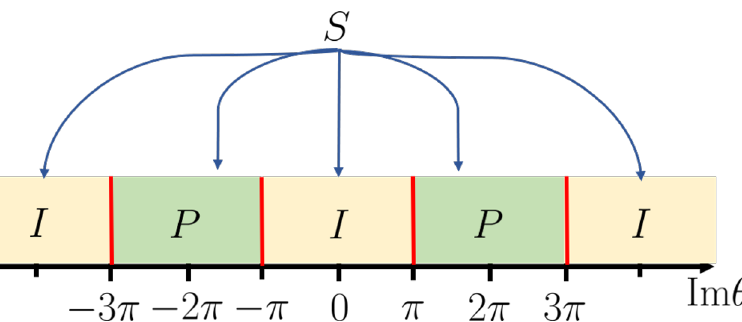
Figure 1 . IR fate of the deformed line defect L S [ θ ] for different Im θ